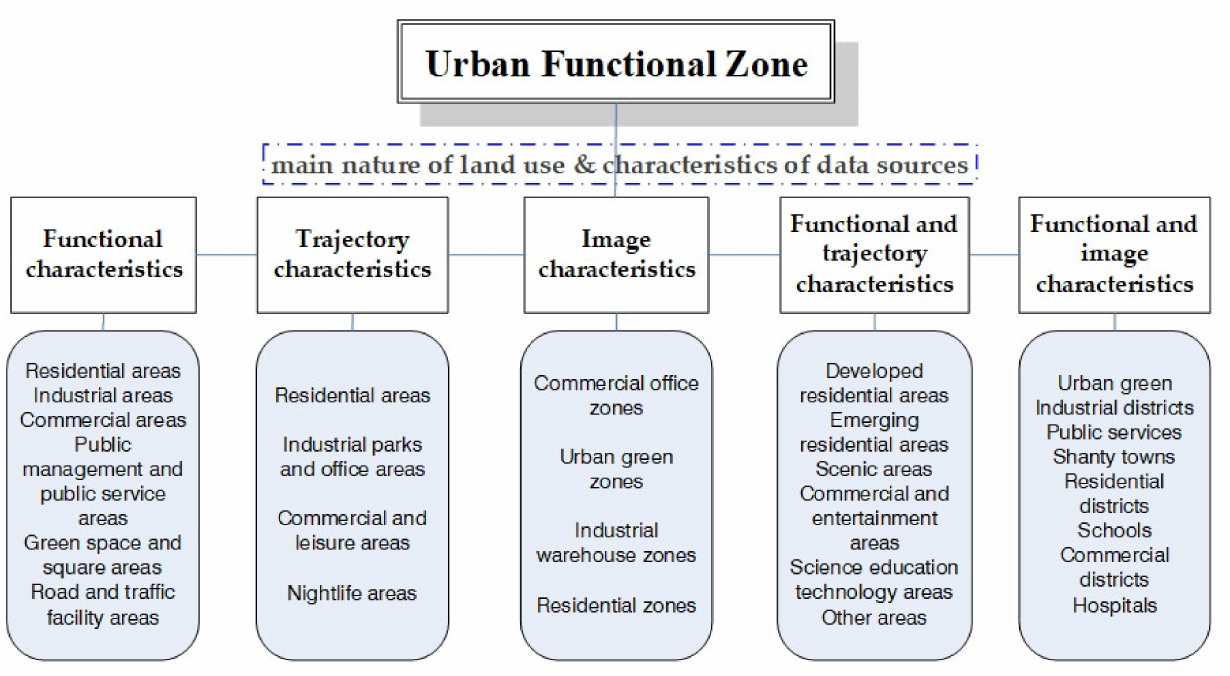
Figure 7. The classification of urban functional zones based on the main nature of land use and data